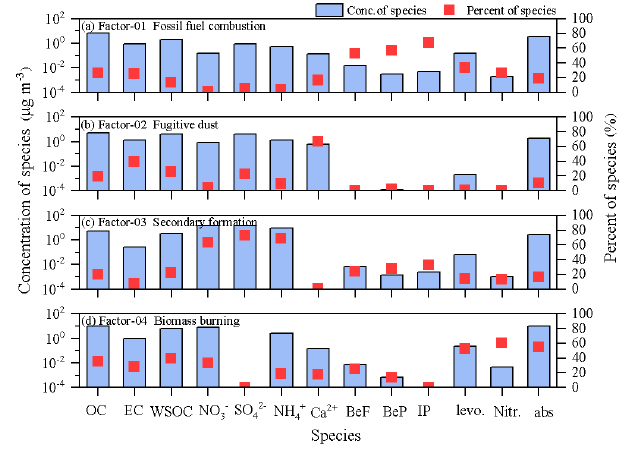
Figure 7. Factor profiles resolved by PMF mode during the winter and summer sampling period. The bars represent the concentrations of species and the dots represent the contributions of species ap- pointed to the factors (the summer and winter samples were merged together for the PMF analysis due to the limited number of sam- ples).